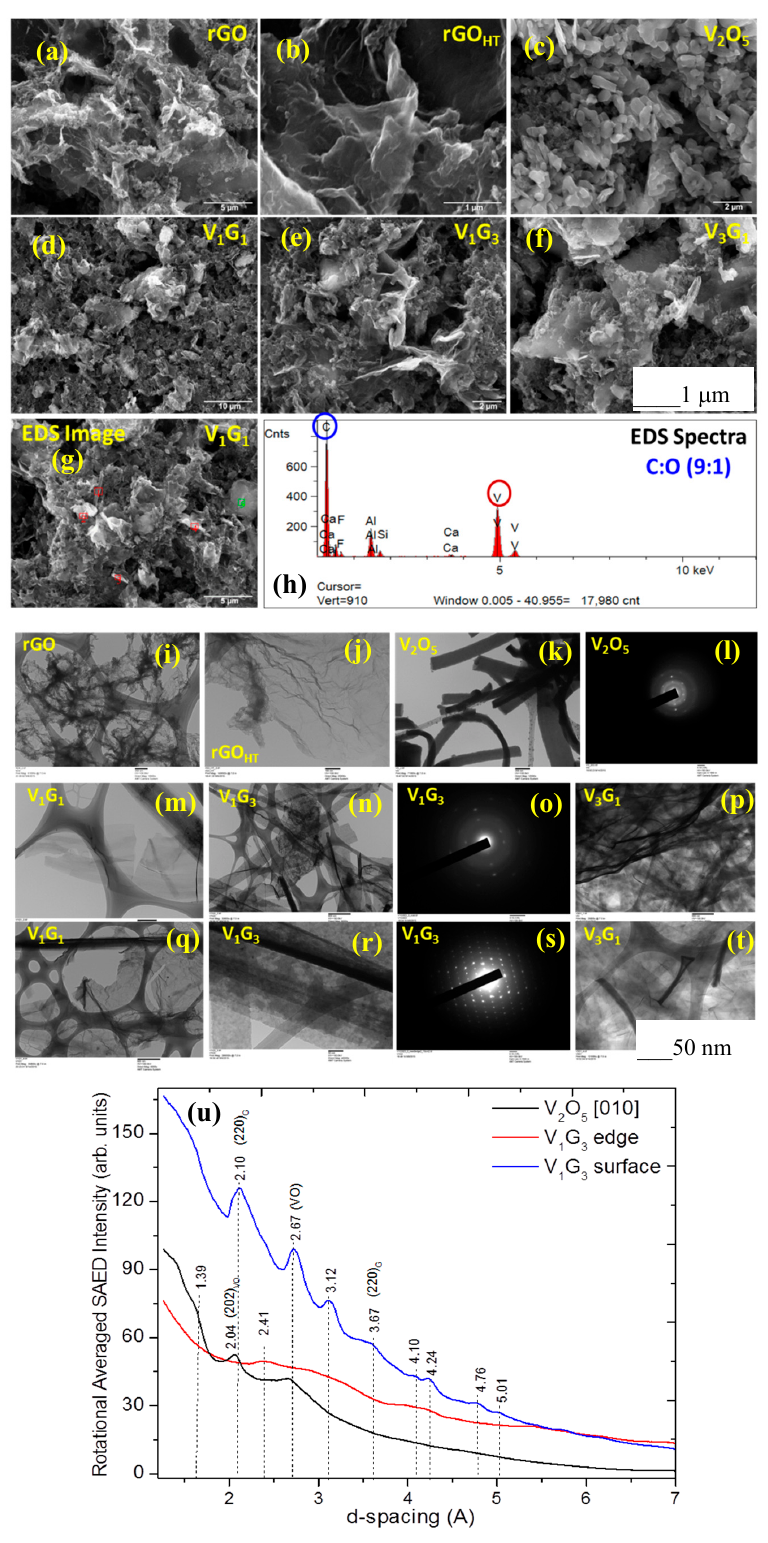
Figure 2. ( a – g ) SEM micrographs; ( h ) EDS spectra; TEM micrographs of ( i ) rGO; ( j ) rGO HT ; ( k ) V 2 O 5 ; ( m , q ) V 1 G 1 ; ( n , r ) V 1 G 3 ; ( p , t ) V 3 G 1 ; ( l , o , s ) SAED and ( u ) the real space (d hkil ) intensity pattern revealing the crystal structure of ‘hybrids’ for the representative samples studied.